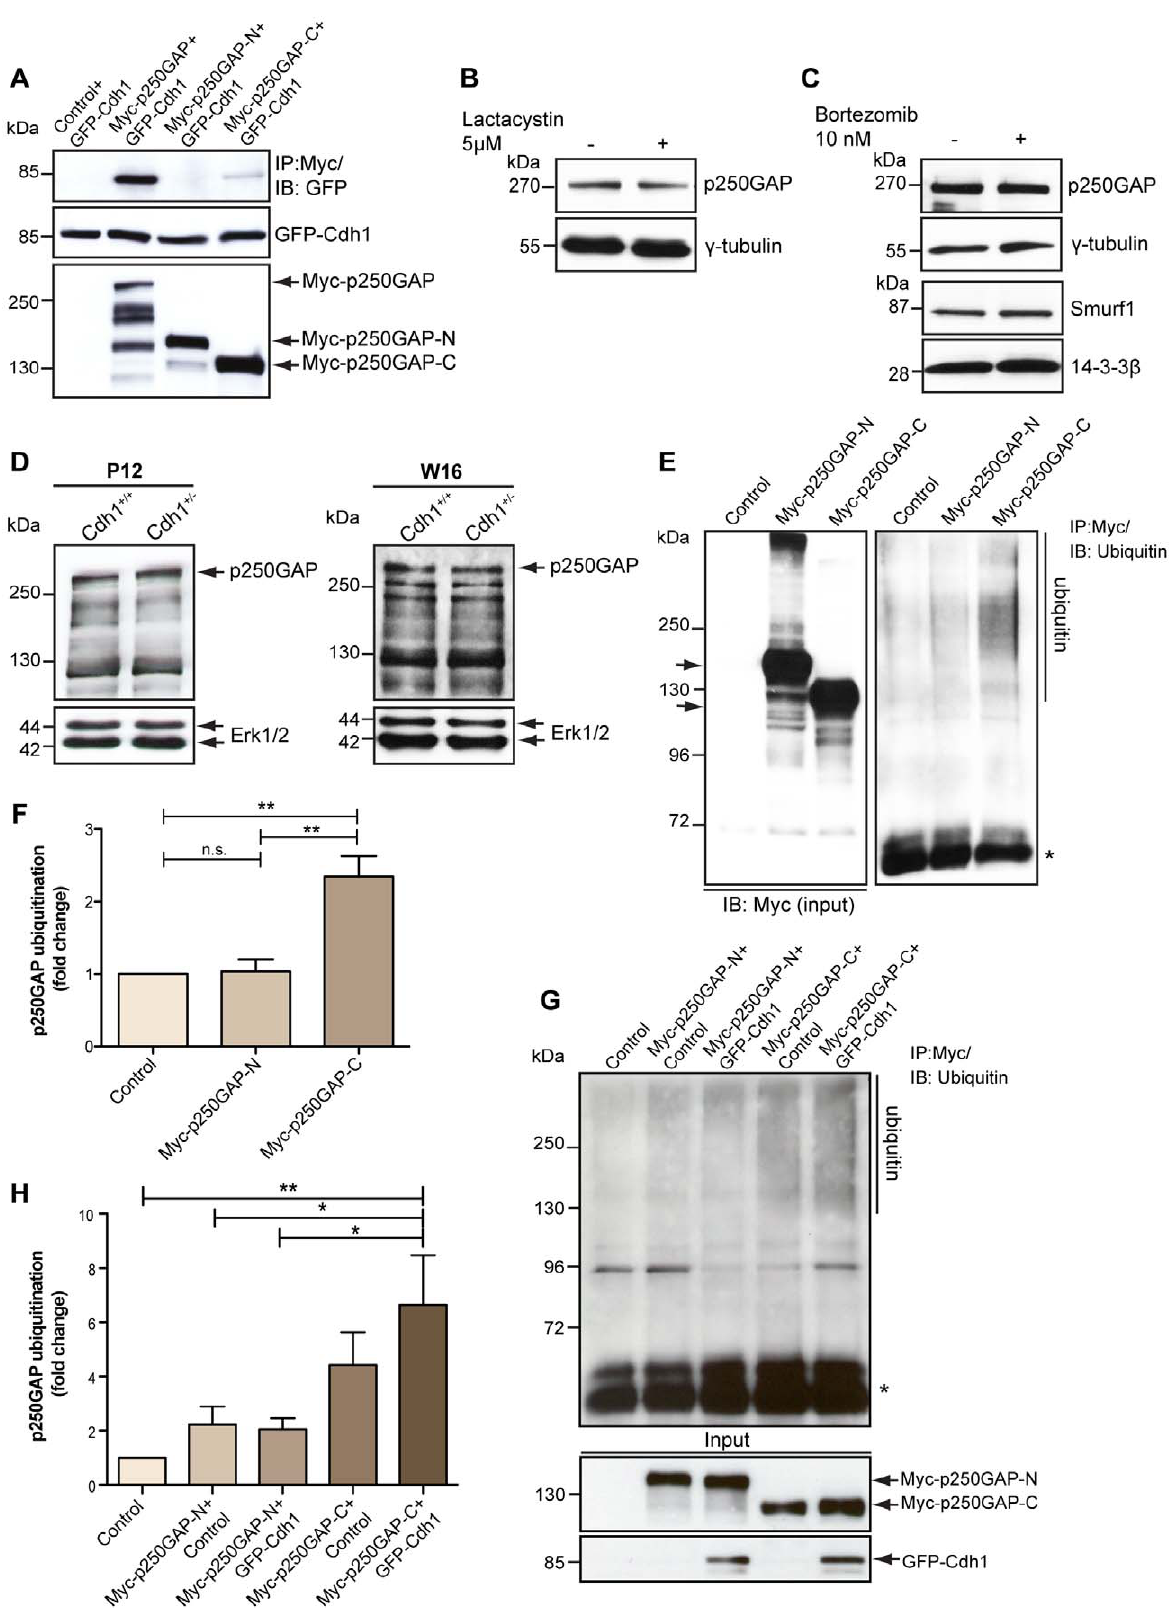
Figure 3. p250GAP is ubiquitinated but not degraded by the proteasome. A. 293T cells were transfected with GFP-Cdh1 together with control vector pCMV-Myc, or plasmids encoding Myc-tagged full length, N- or C-terminal fragments of p250GAP (Myc-p250GAP, Myc-p250GAP-N or